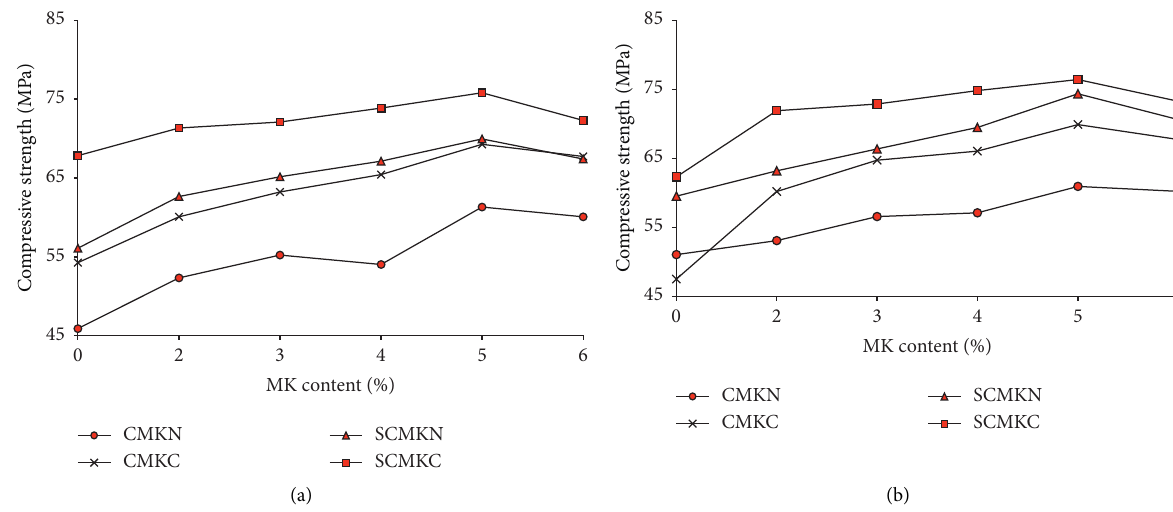
Figure 9: Compressive strength of concrete containing metakaolin at (a) 28 days and (b) 56 days [16].